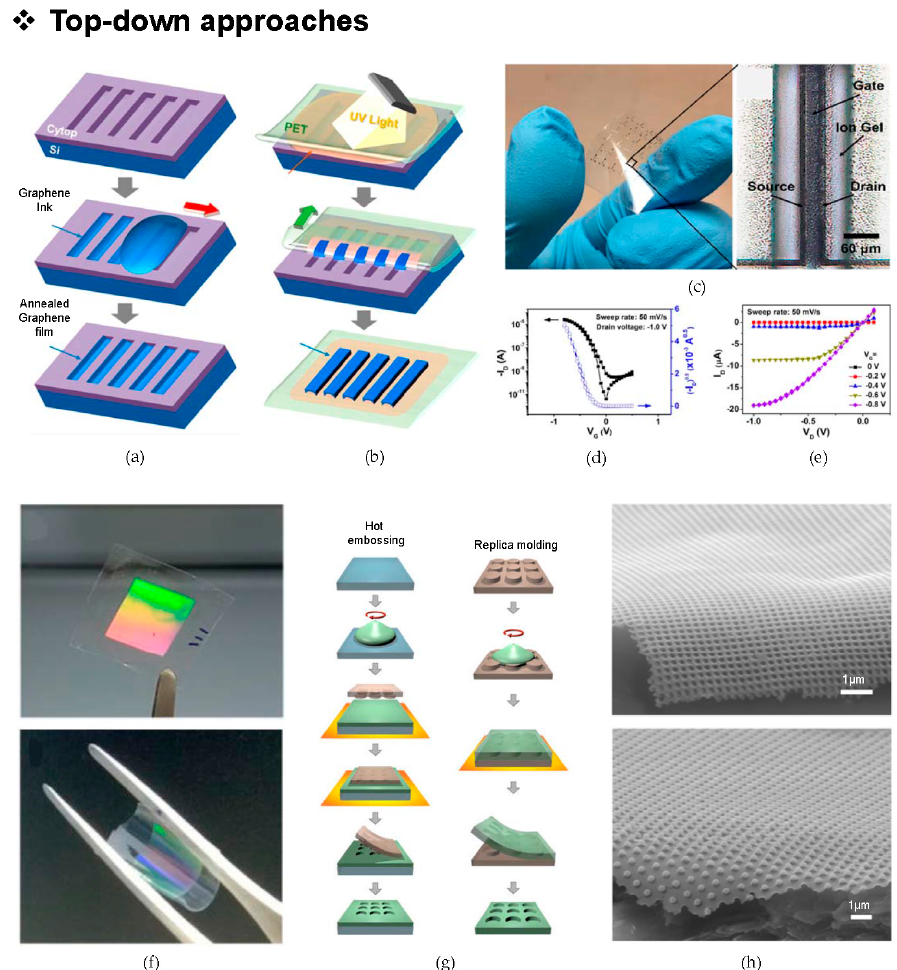
Figure 1. Graphene lines-based flexible transistor/hydroxypropyl cellulose (HPC) photonic thin film with a hexagonal nanopillar structure: ( a ) a schematic of the fabrication of the Cytop/Si mold; ( b ) simple procedures for transferring graphene lines from the Cytop/Si mold to the polyethylene terephthalate (PET) flexible substrate; ( c ) an image of flexible electrolyte-gated transistor (EGT) arrays, the magnified picture shows the composition of each transistor; ( d , e ) the transfer and output characteristics of the graphene electrodes, Reproduced with permission from 2017 ACS NANO [37]; ( f ) images of an HPC photonic crystal (top) and its mechanical flexibility with a free-standing property of the design (bottom); ( g ) schematics of two fabrication processes to make HPC photonic films-hot embossing and replica molding methods. The blue-colored slide indicates the glass substrate, the green one for HPC, and the brown one for hard polydimethylsiloxane (h-PDMS); ( h ) special hexagonal nanopillar images obtained by scanning electron microscopy (SEM) in the lateral view. Paper substrates are used to imprint the predesigned nanopattern. Reproduced with permission from 2018 Nature [38].